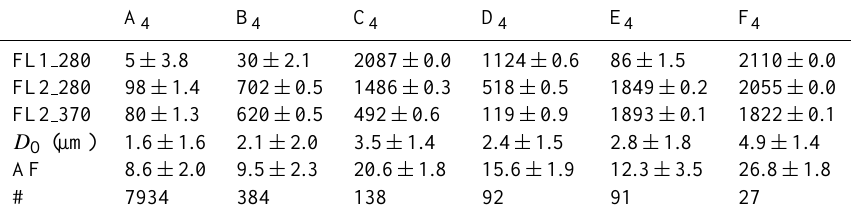
Table 5. Cluster averages and standard deviations for the WIBS4 data set. Bottom row shows the number of constituent measurements.